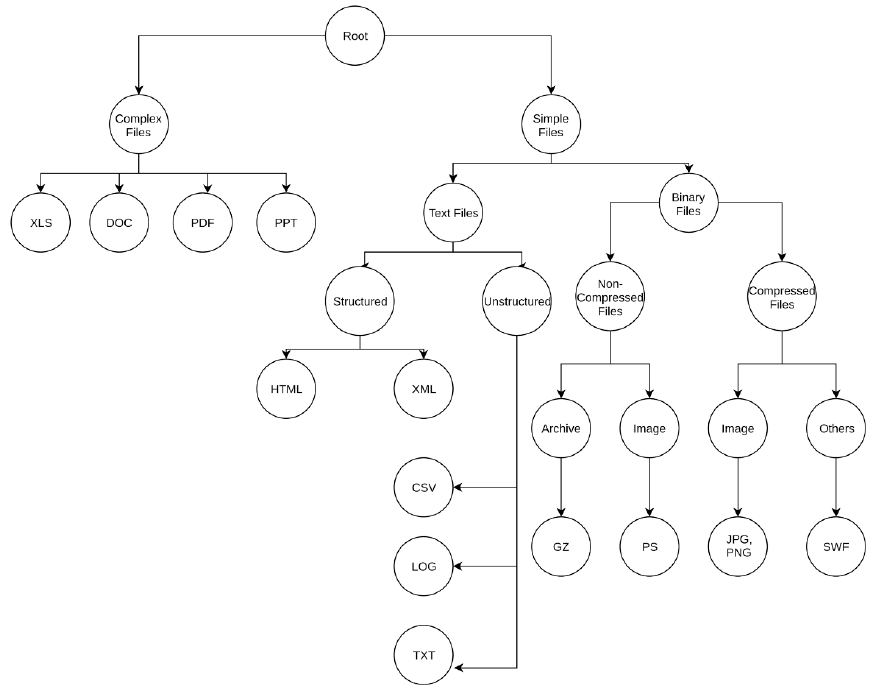
Figure 2. Hierarchy illustration for the files for experiment 2.